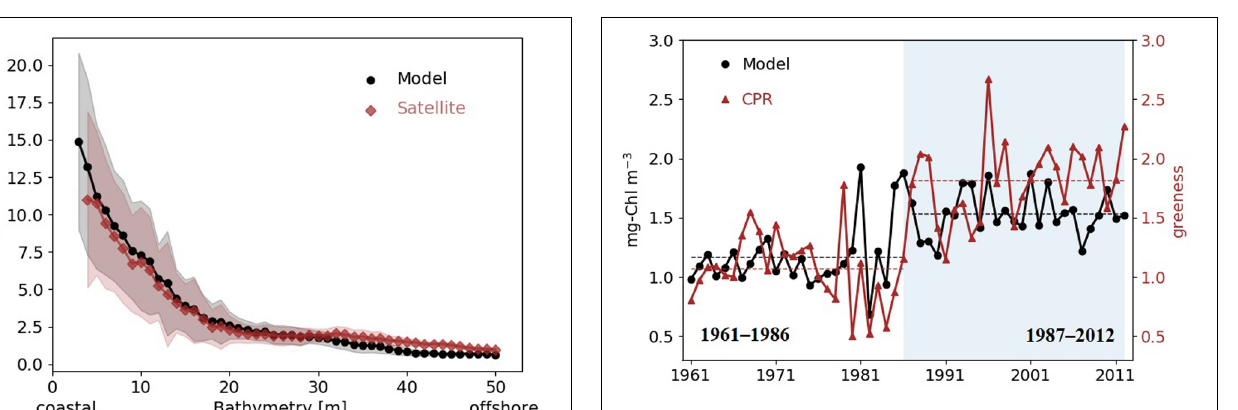
FIGURE 3 | Simulated surface annual mean Chl (black circles) and annual mean CPR greenness (red triangles) in the SNS. Shaded area shows the years after the change point detected by binary segmentation in both simulation and CPR data (1987–2012). Dashed lines are mean values of the two time periods.